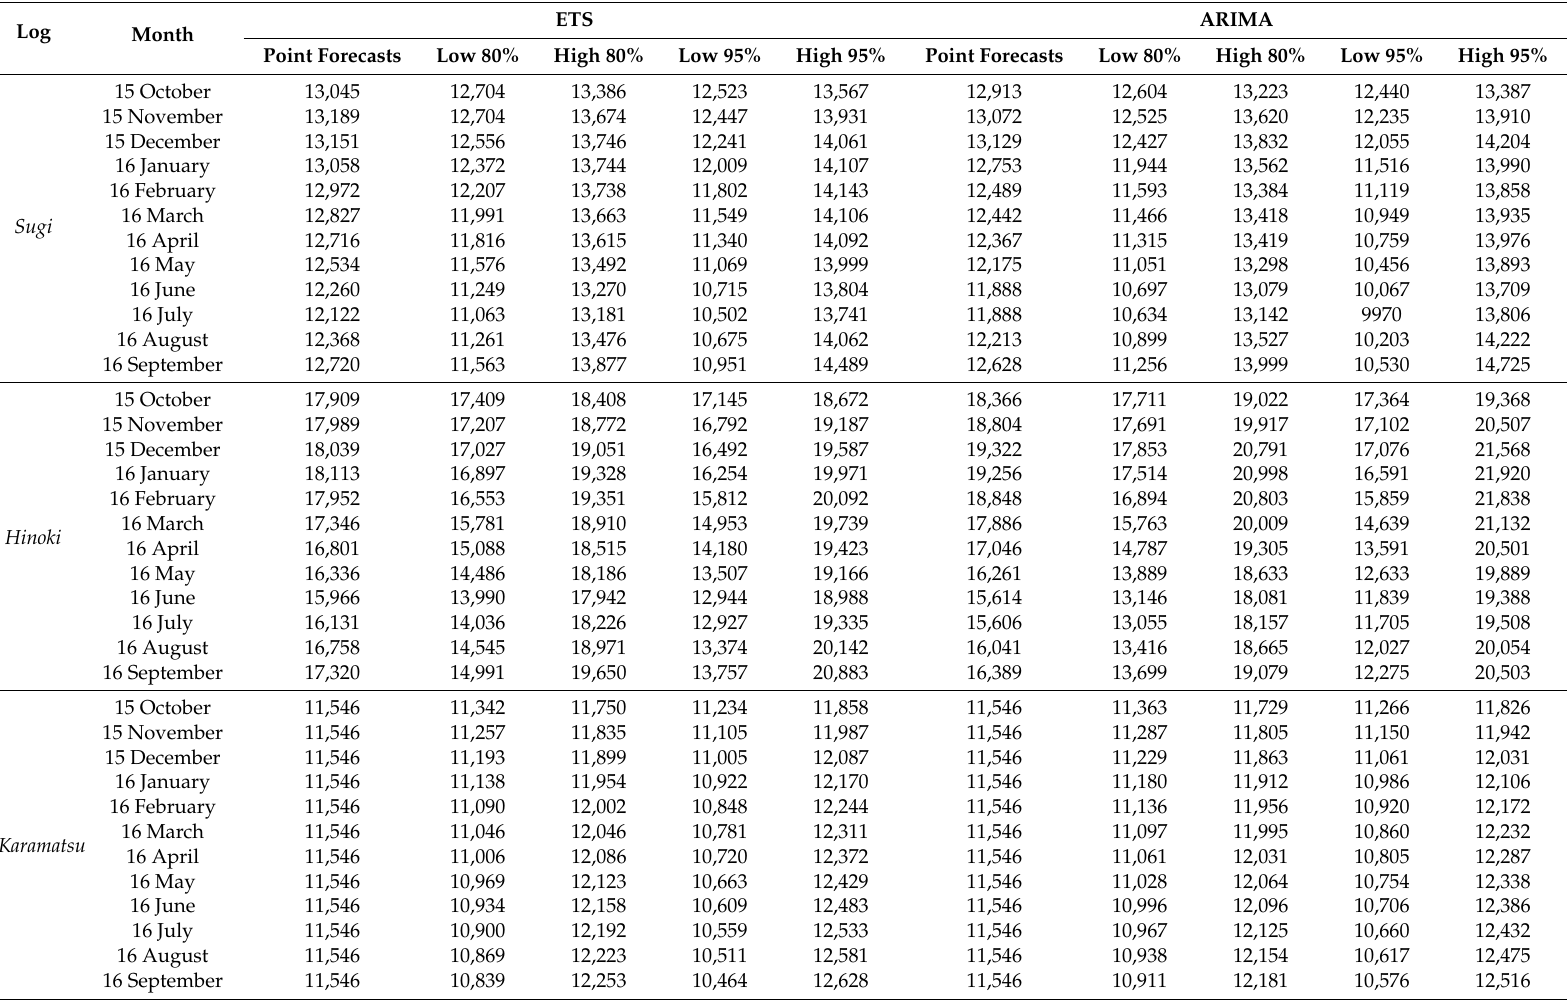
Table 1. Point forecasts and forecast intervals at 80% and 95% level. Unit: Yen. ETS, exponential smoothing method; ARIMA, autoregressive integrated moving